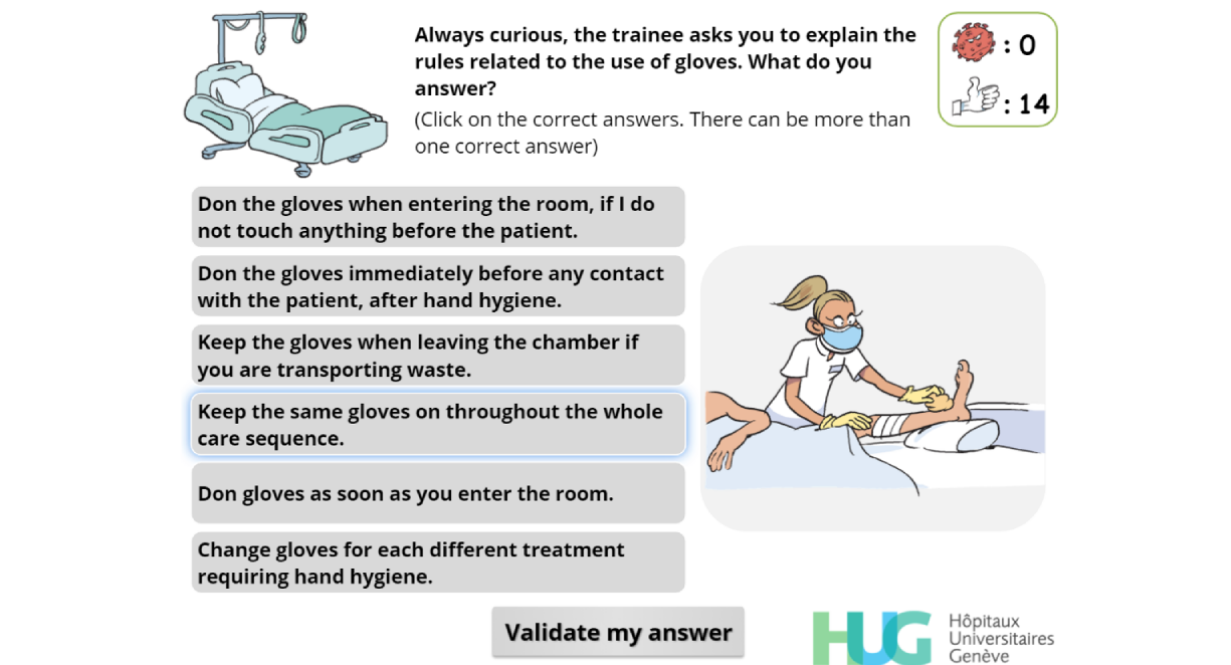
Figure 17. Multiple-choice interaction. The player must choose in which situations they should wear or change gloves. Illustrations change as the cursor hovers over the buttons on the